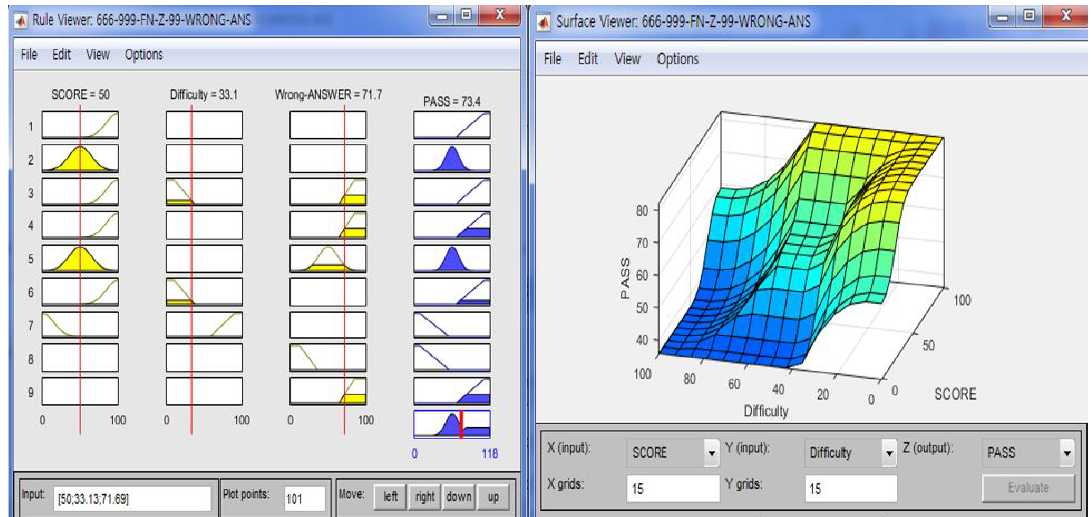
Figure 8. Computer simulation result.